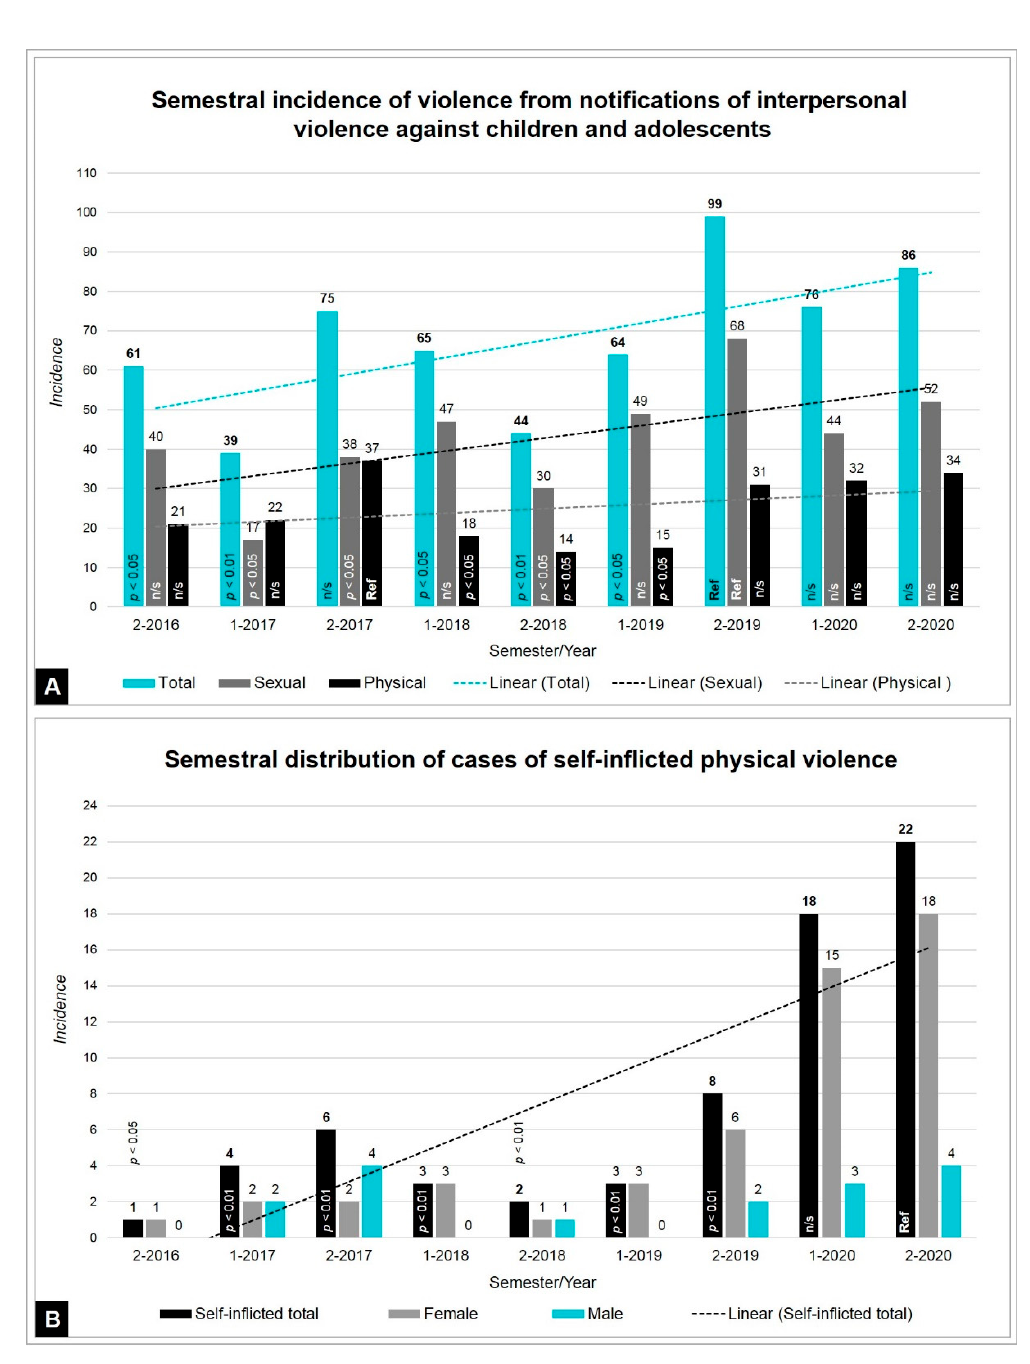
Figure 2. Indicators of the semestral epidemiological increase of violence. ( A ) Semester absolute totals and stratification by sexual and physical types. ( B ) Semestral incidence of self-inflicted violence stratified by sex of victims.